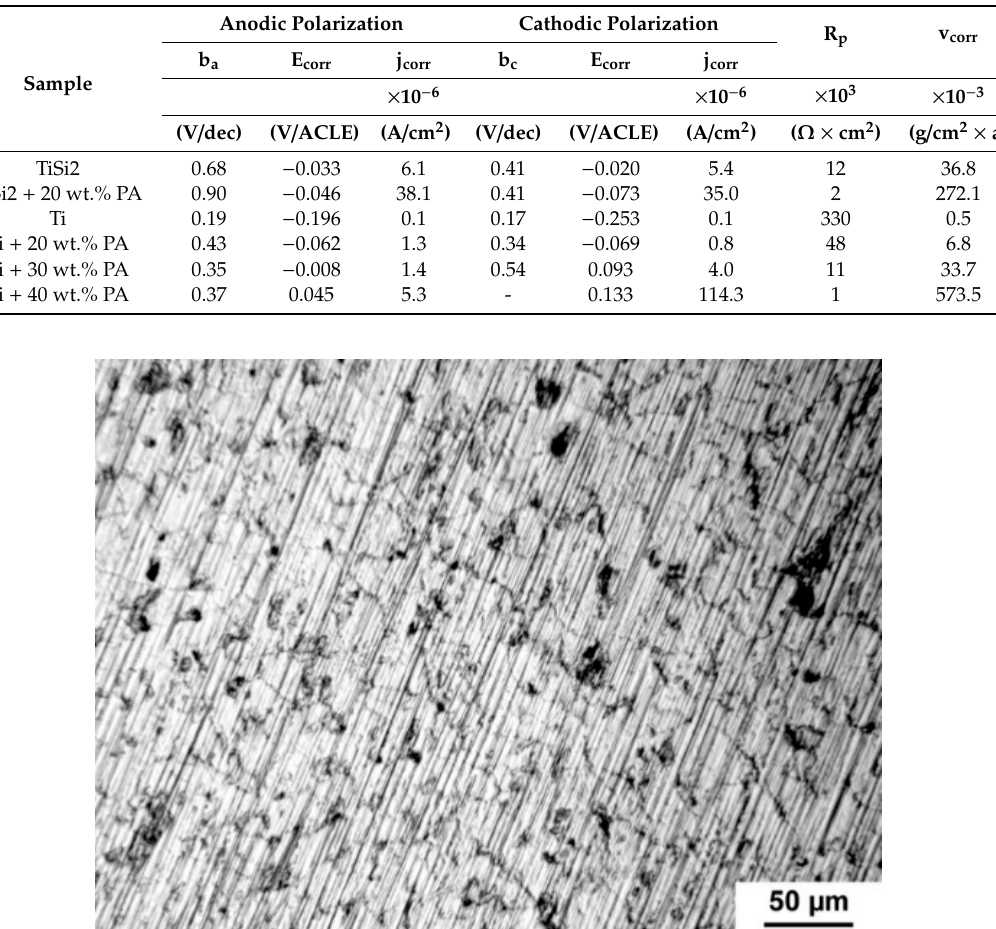
Table 5. Results of anodic and cathodic polarization.